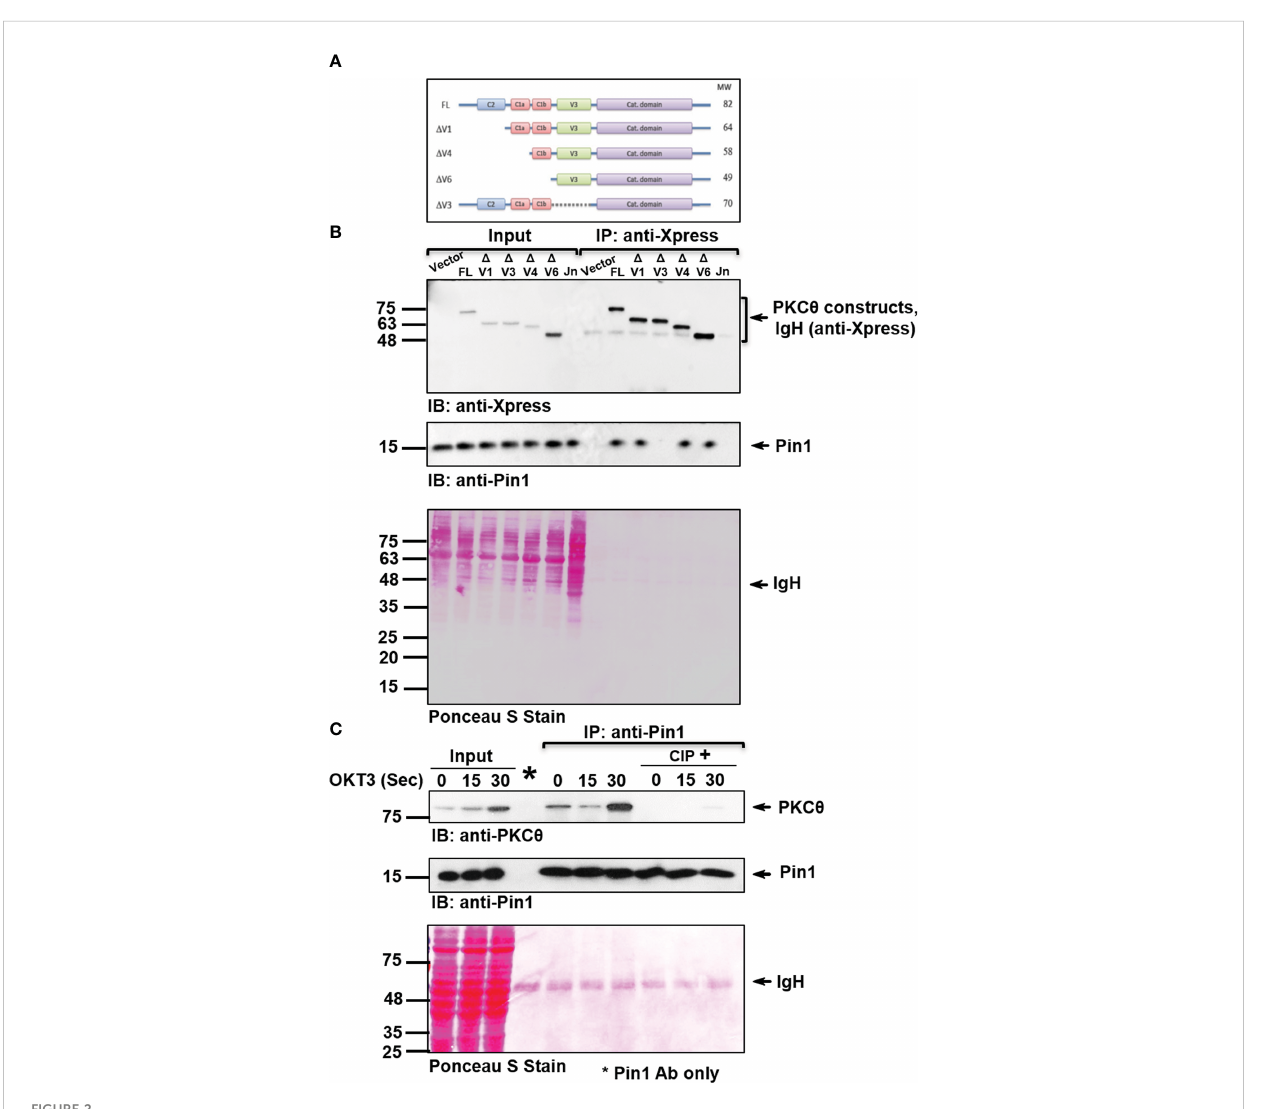
FIGURE 2 PKC q -V3 is integral for the phosphorylation-dependent binding of Pin1. (A) A schematic representation of Xpress-tagged wild-type or mutant PKC q constructs. (B) Immunoblot (IB) analysis of Xpress (PKC q ) IP or whole cell lysates from COS-7 cells transfected with an empty vector or the indicated Xpress-tagged PKC q vectors. Untransfected Jurkat E6.1 (Jn) T cells served as a negative control. (C) Jurkat TAg cells were stimulated for the indicated time intervals with anti-CD3 mAb (OKT3). Immunoprecipitates (IP) were treated with or without calf intestinal phosphatase (CIP). Following incubation, the samples were subjected to immunoblotting (IB) as indicated. Membrane staining with Ponceau S monitored the equal loading of proteins in all lanes. Data are representative of three independent experiments. Molecular weight markers (in kDa) are indicated on the left and arrow mark positions of the indicated protein bands. IgH, Ig heavy